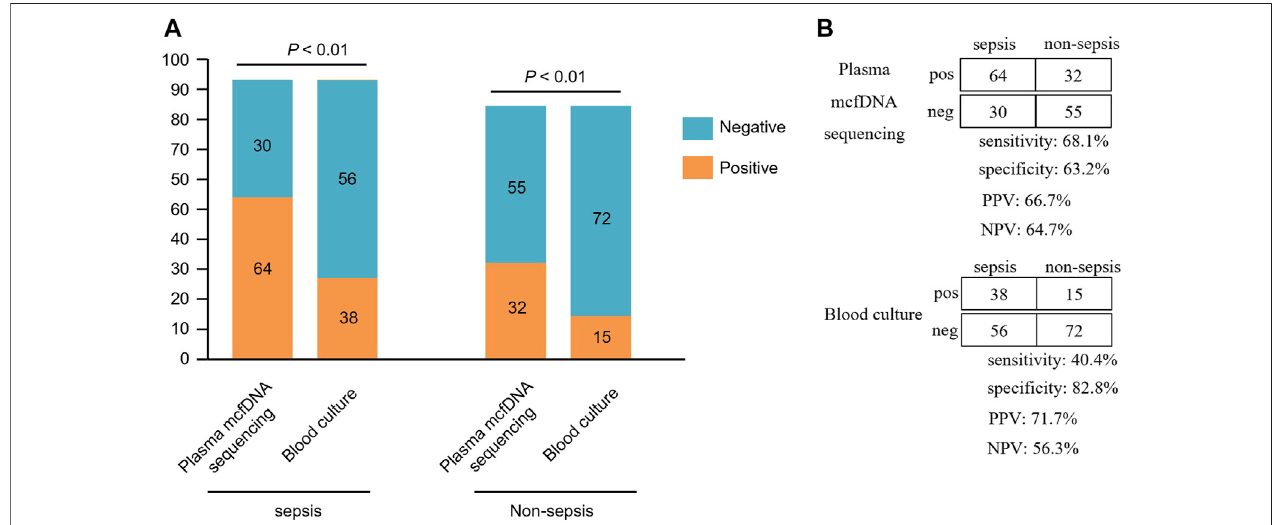
FIGURE3| Comparisonofplasmamicrobialcell-freeDNA(mcfDNA)sequencingandbloodcultureforsepsisgroupandnon-sepsisgroup. (A) ,Numberofpositive results samples for pairwise plasma NGS and blood culture testing is plotted against the sepsis and non-sepsis. (B) , The diagnostic performance of plasma mcfDNA sequencing and blood culture testing for differentiating sepsis from non-sepsis is shown by the contingency tables. NPV, negative predictive value; PPV, positive predictive value. pos, positive; neg, negative.